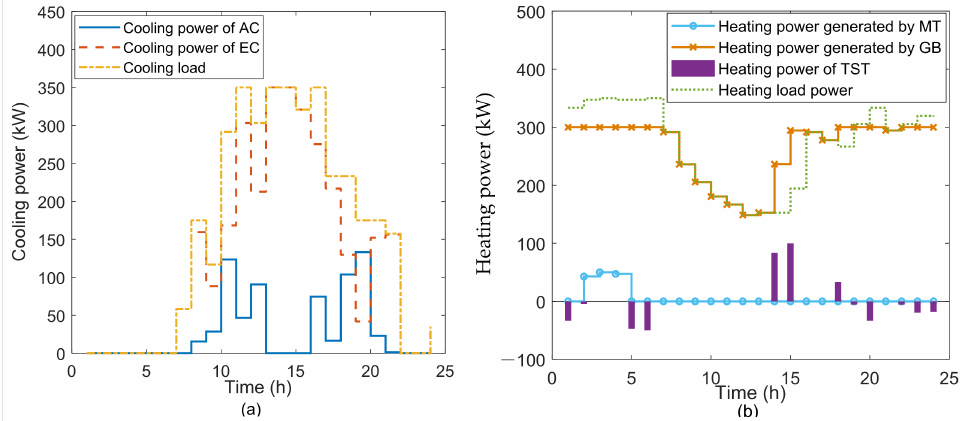
Figure 10. Optimal operation results of cooling power and heating power ( a ) The cooling power in summer cold ( b ) The heating power in